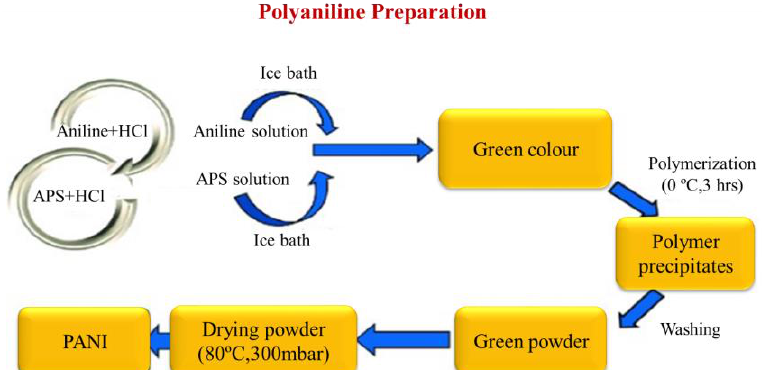
Figure 4. Oxidative polymerization method of polyaniline. Reproduced from Results Phys, vol 14, Fayzan, M.; Nawaz, A.; Khan, R.; Javed, S.; Tariq, A.; Azeem, M.; Riaz, A.; Shafqat, A.; Cheema, H.M.; Aftab, M.; et al., Results in Physics EMI shielding properties of polymer blends with inclusion of graphene nano platelets, 102365, Copyright (2019), with permission from Elsevier.